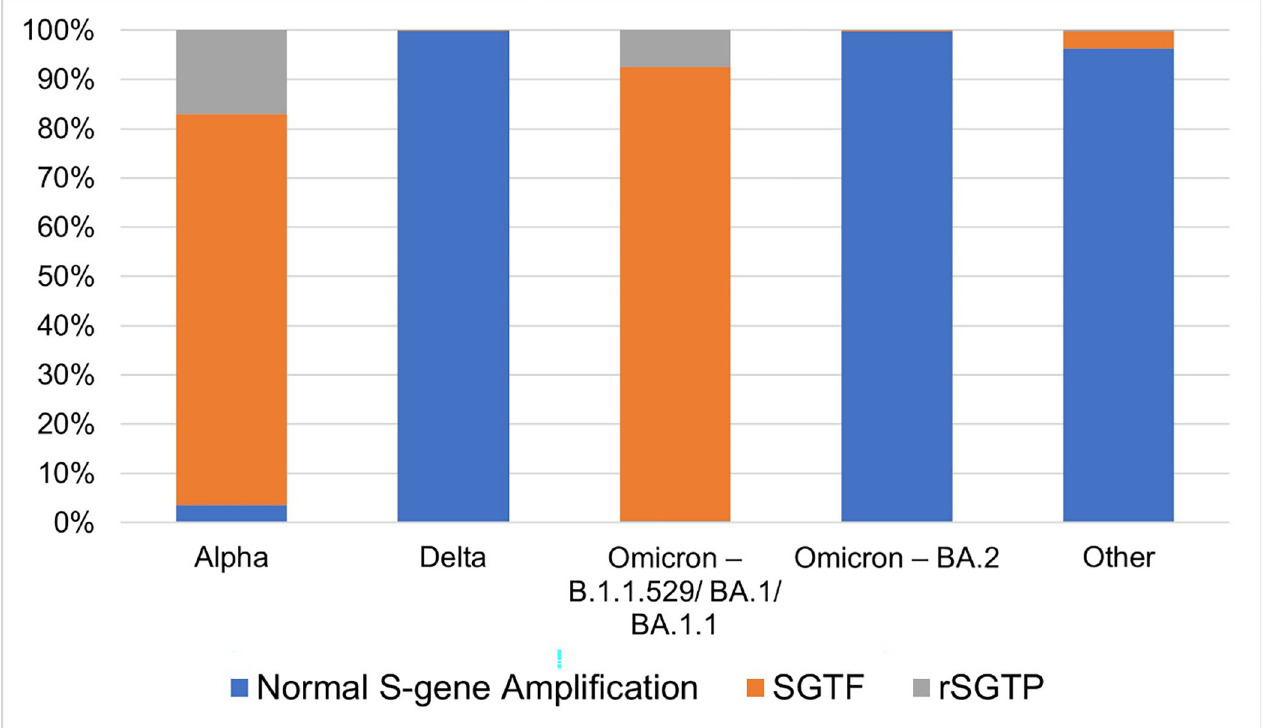
Fig 1. Frequency of S-gene target status in WGS confirmed